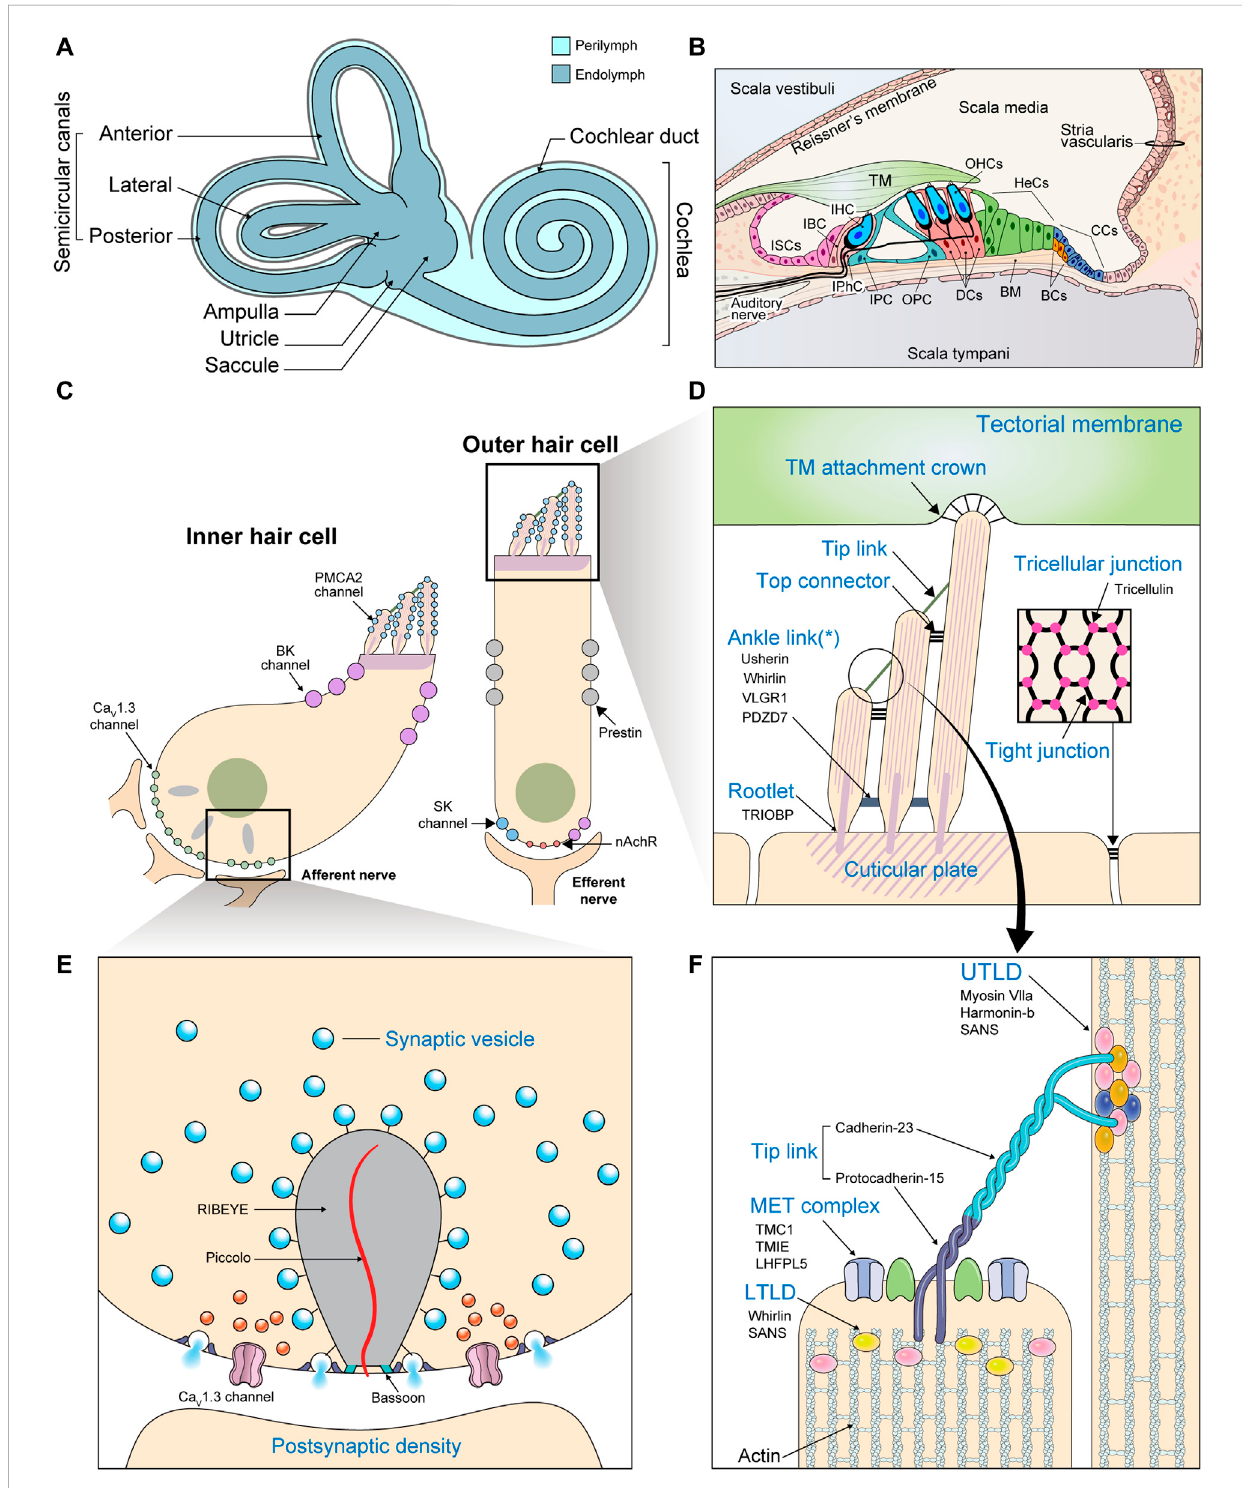
FIGURE 2 Gross and molecular anatomy of the mammalian cochlea. (A) The structure of the inner ear. (B) Transverse section of the cochlea. (BC: Boettcher cell; BM: Basilar membrane; CC: Claudius cell; DC: Deiters cell; HeC: Hensen cell; IBC: Inner border cell; IHC: Inner hair cell; IPC: Inner pillar cell; IPhC: Inner phalangeal cell; ISC; Inner sulcus cell; OHC:Outer hair cell; OPC: Outer pillarcell) (C) Enlargedview ofthe twokinds of cochlear HCs depicting the locations of the most important ion channels. Efferent fi bers from the olivary complex synapse mainly with OHCs. (BK channel: large-conductance Ca 2+ -activatedK + channel;nAChR: α 9/ α 10nicotinicacetylcholinereceptor;SKchannel:small-conductanceCa 2+ -activatedK + channel) (D – F) Important structures are labeledin bluewith their molecularconstituents listedbelowin black. (D) Enlargedview of theHCapical surfacedepicting various types of hair bundle links. The asterisk (*) indicates that ankle links are transient structures absent from the mature hair bundle. (Inset: A section parallel to the cochlear fl oor at the level of the tight junctions. Specialized structures called tricellular junctions are formed at points of tricellular contact.) (E)